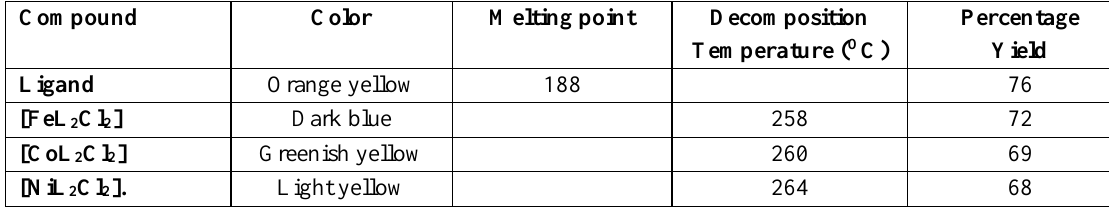
Table 1. Physical properties and analytical data of Schiff base and its metal (II) complexes. Compound